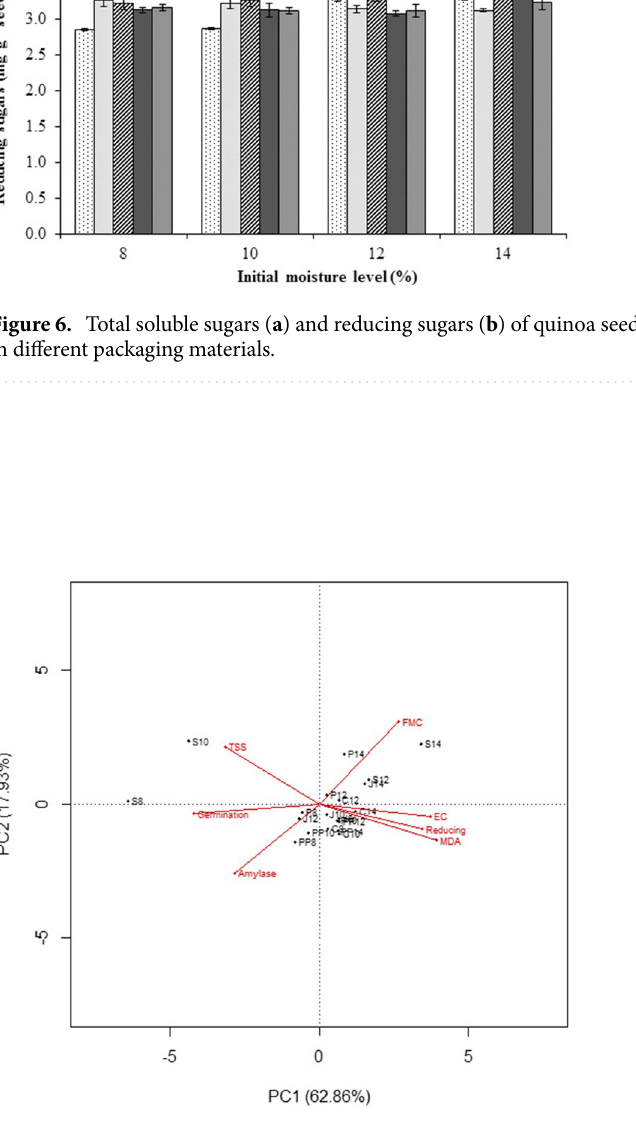
Figure 7. Biplot of germination, EC and various biochemical attributes of quinoa seeds stored in different packaging materials at varying levels of seed moisture contents. S, Super Bag; P, Paper bag; PP, Polypropylene bag; J, Jute bag, C, Cloth Bag. Initial moisture levels: 8, 10, 12 and